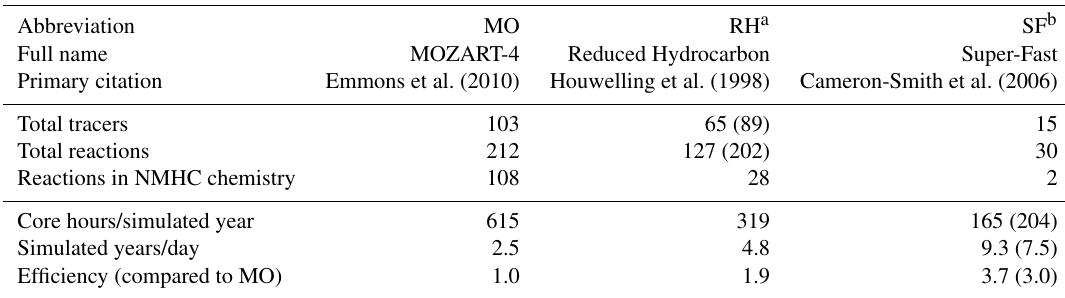
Table 1. Summary and comparison of the MOZART-4 (MO), Reduced Hydrocarbon (RH), and Super-Fast (SF) mechanisms included in this paper. All runs were conducted on the NCAR Cheyenne system with 64 CPUs on two nodes without any load optimization, and the values in this table represent the cost of the entire CESM CAM-chem model, not just the chemistry component. In this study, we removed many stratospheric species (see text), so we include both the modified and unmodified (in parentheses) RH mechanisms. The MO and RH mechanism include